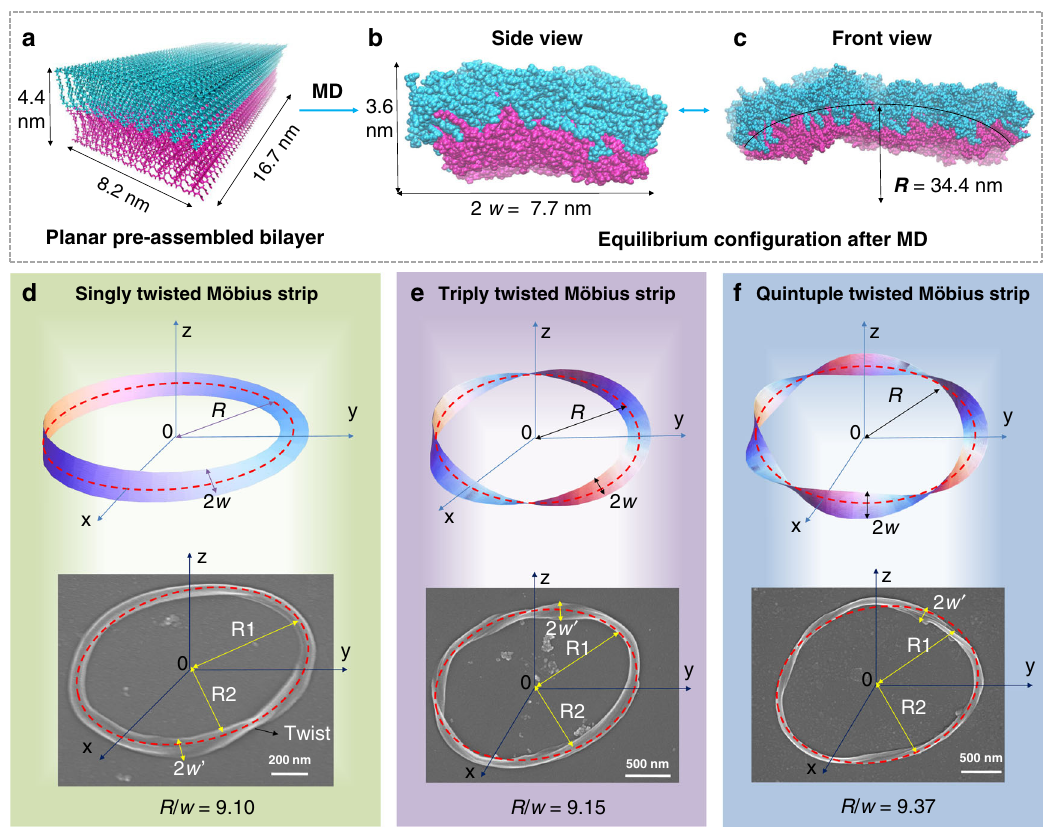
Fig. 6 Molecular dynamic (MD) simulation and mathematical analysis. a Planar pre-assembled bilayer structure containing 900 molecules with 45*10*2 array, H 2 A, and HA − molecules were colored in magenta and cyan, respectively. b The equilibrium con fi guration for H 2 A/HA − after MD simulation, side view, the length of the bilayer is about 3.6 nm, the width of the twist is about 7.7 nm. c The equilibrium con fi guration after MD simulation, front view, the curvature radius of the twist is about 34.4nm. d – f Theoretical Möbius strips (upper images) image based on parameters from MD computation and experimental Möbius strips (bottom images) observed from SEM images with different twist numbers. d Singly twisted Möbius strip. e Triply twisted Möbius strip. f Quintuple twisted Möbius strip. Notes: R represents the radius of Möbius strip, R 1 and R 2 represent the long radius and short radius of elliptic Möbius strip, w and w ′ represent the half-width of Möbius strip band. H 2 A =